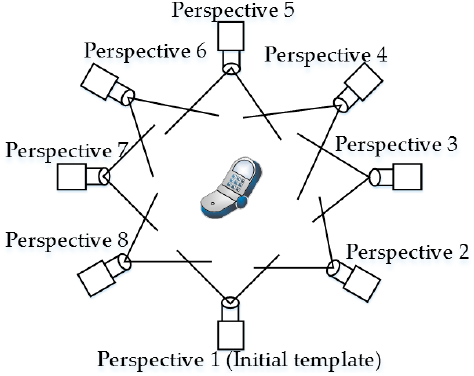
Figure 8. Schematic of multi-view template acquisition